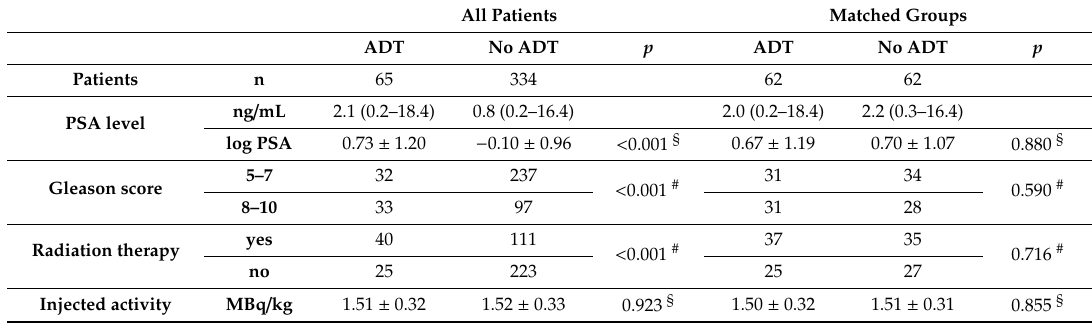
Table 2. By clinical definition [5] and considering PET / CT findings, 42 patients of the final ADT group had